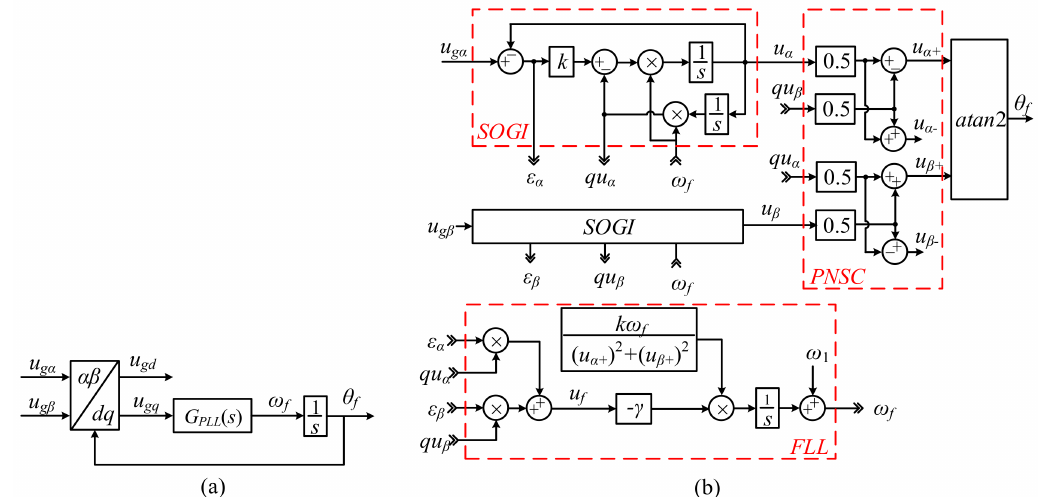
Figure 4. Block diagram of ( a ) a basic synchronous reference frame PLL (SRF-PLL); ( b ) a dual second order generalized integrator frequency locked loop (DSOGI-FLL) based grid synchronization with frequency locked loop (FLL) gain